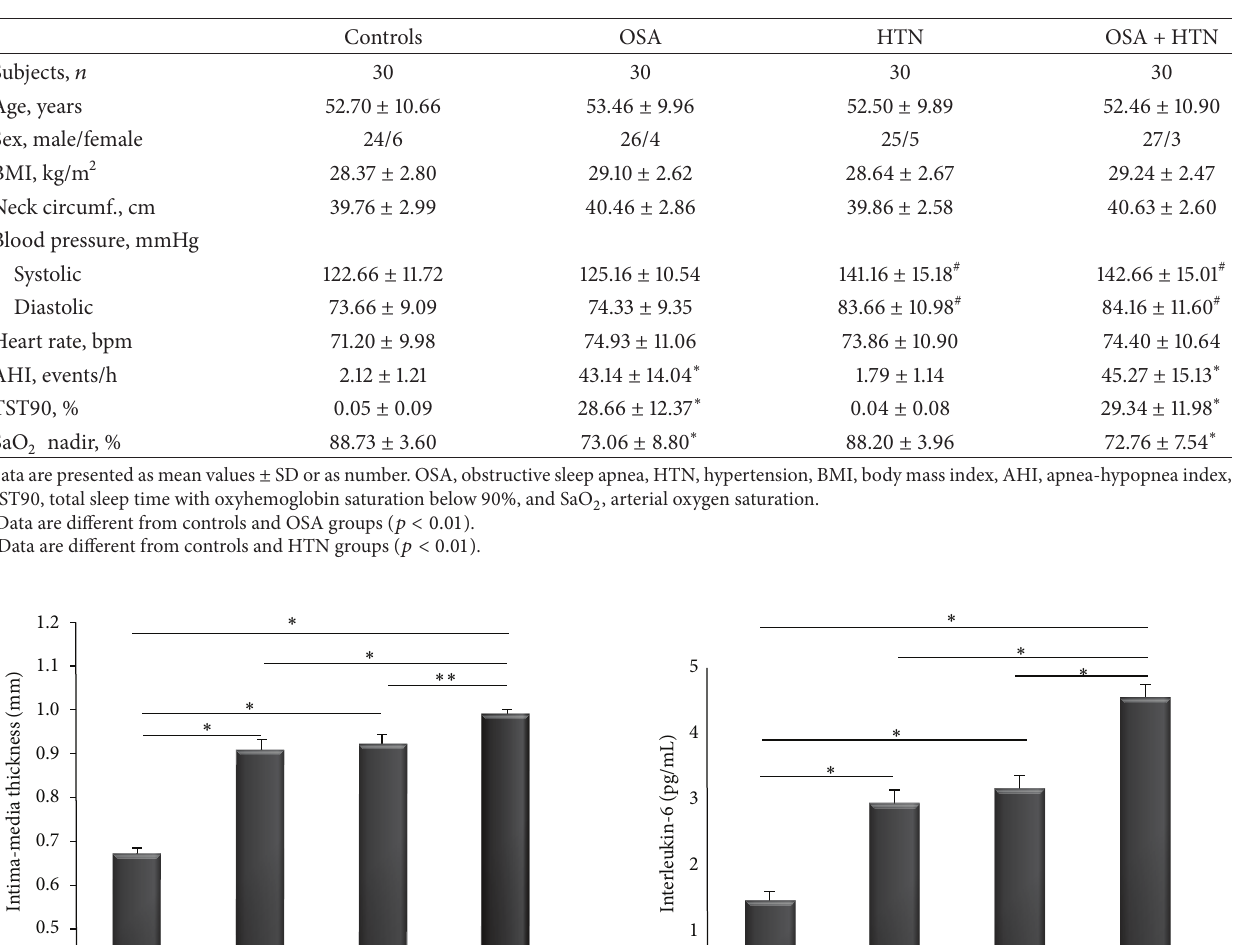
Table 1: Demographic and polygraphic characteristics of study population.